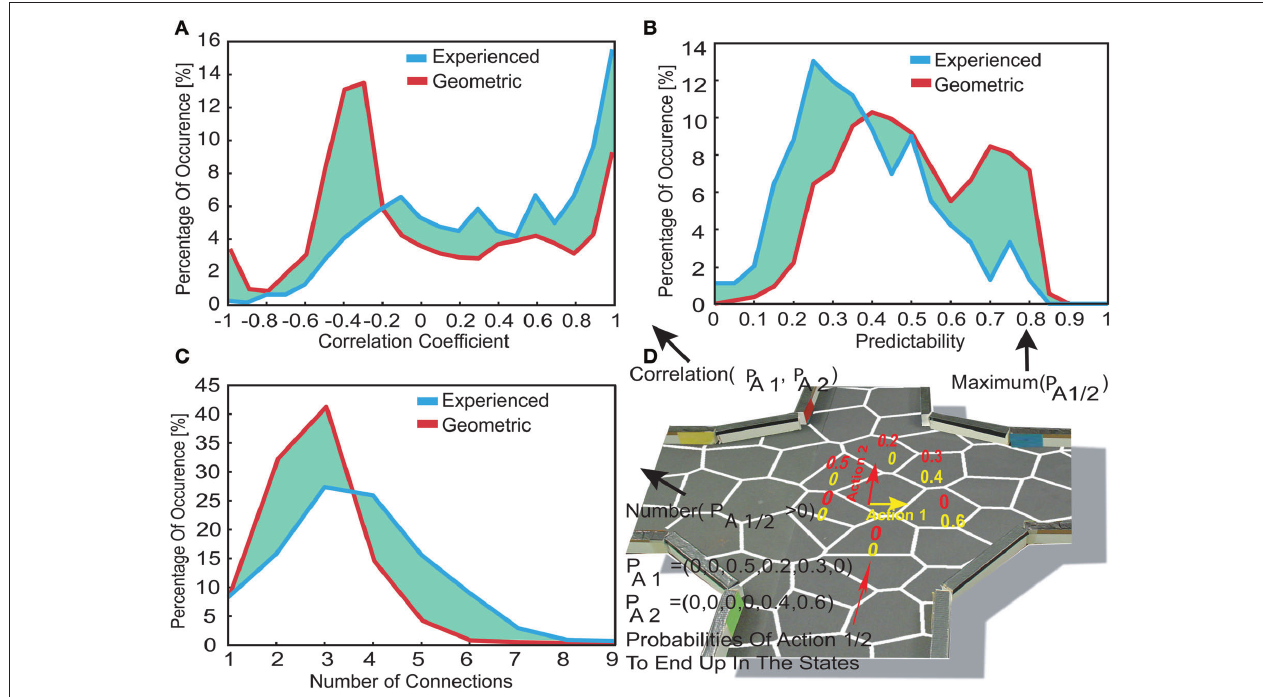
Figure  | (A) Occurrence of correlation coefficients of the different actions. In order to do so we correlated the transition probabilities to the neighboring states of the actions as shown in the example. (B) The occurrence of the action’s highest transition probability, defined as the actions predictability. (C) The actions